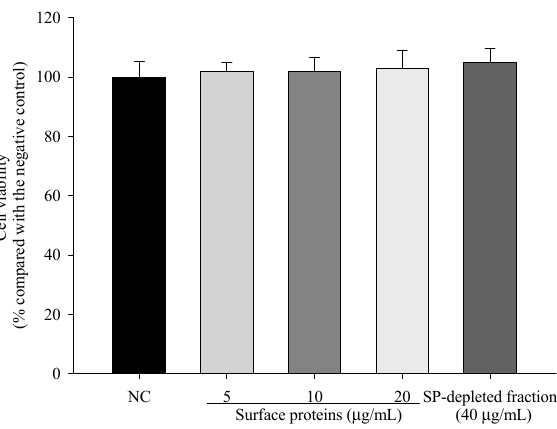
Figure 9. Cytotoxicity of surface proteins (SPs) extracted from MJ2 on hFOB 1.19 cells. The values indicate the mean ± SD of three independent experiments performed in triplicate.